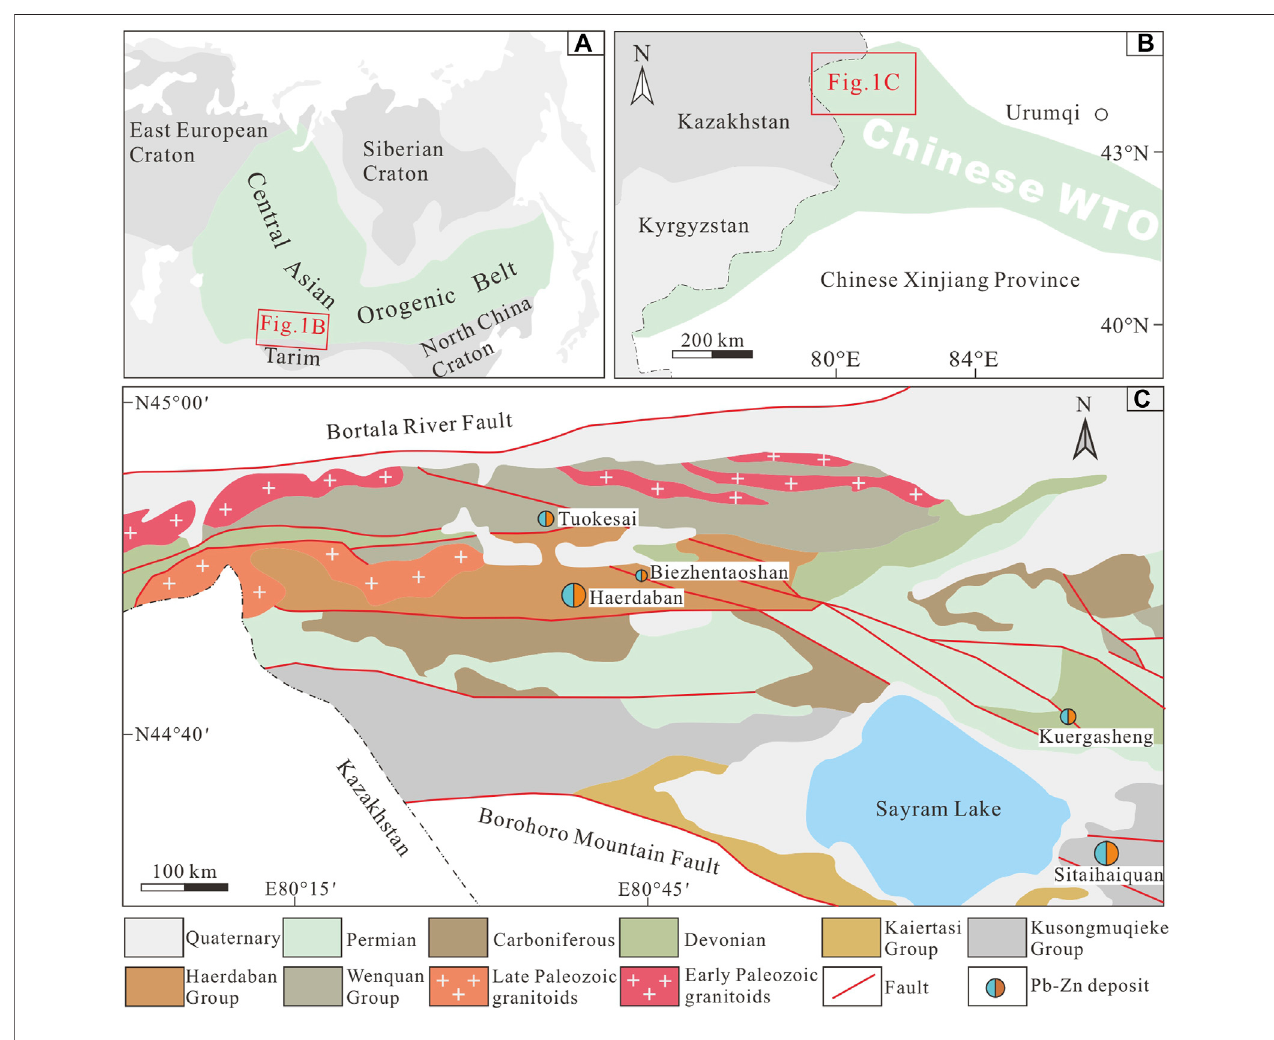
FIGURE 1 | Geological map of the Sayram Lake area (modi fi ed after Xue et al., 2014a).